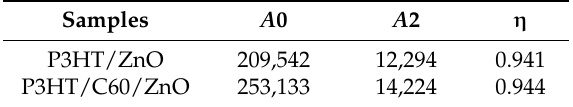
Figure 4. Dynamic fluorescence spectra of the ( a ) unmodified; and ( b ) C60 modified P3HT/ZnO nanorods dispersed in CB. The blue bar, the purple line and the black ball are referred to individual ZnO nanorod, P3HT molecular chain and pyrrolidine tris-acid molecule. Table 1. Quenching efficiencies derived from dynamic fluorescence